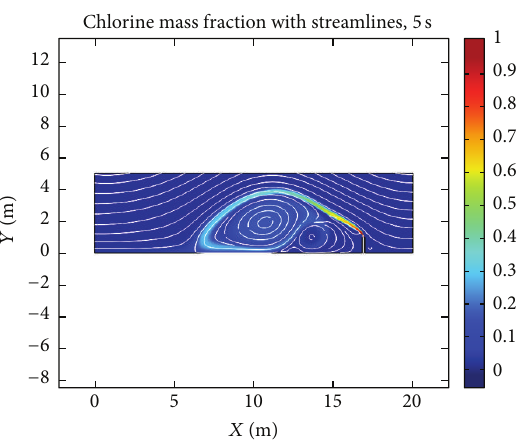
Figure 13: Chlorine mass fraction with streamlines after 1s. Figure 14: Chlorine mass fraction with streamlines after 5 s.